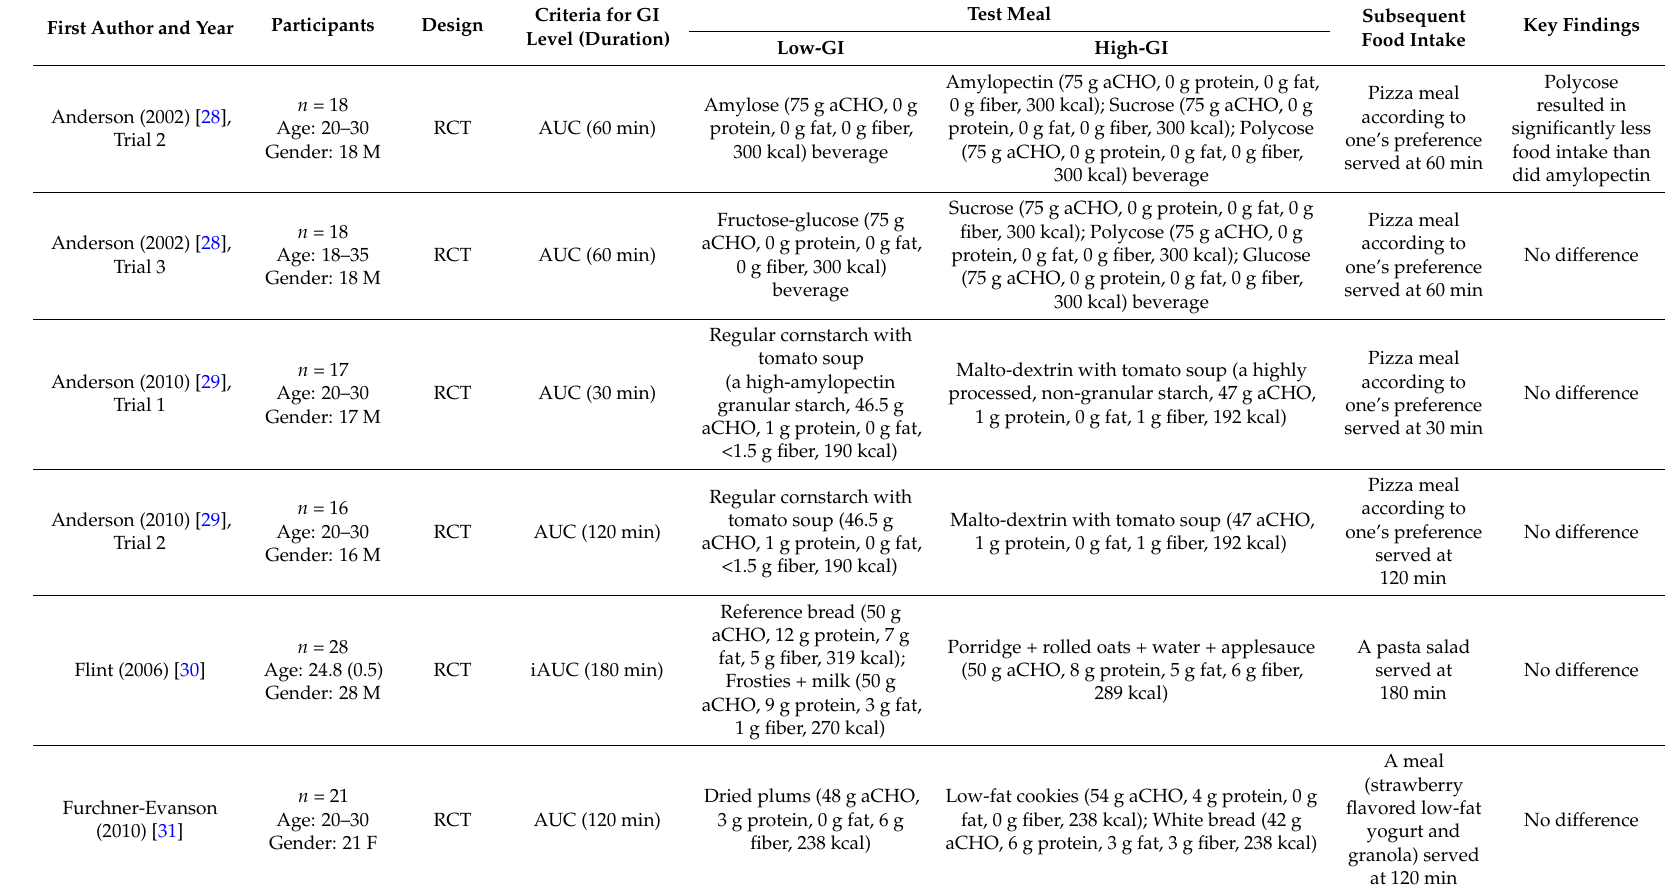
Table 1. Characteristics of eligible studies included in this